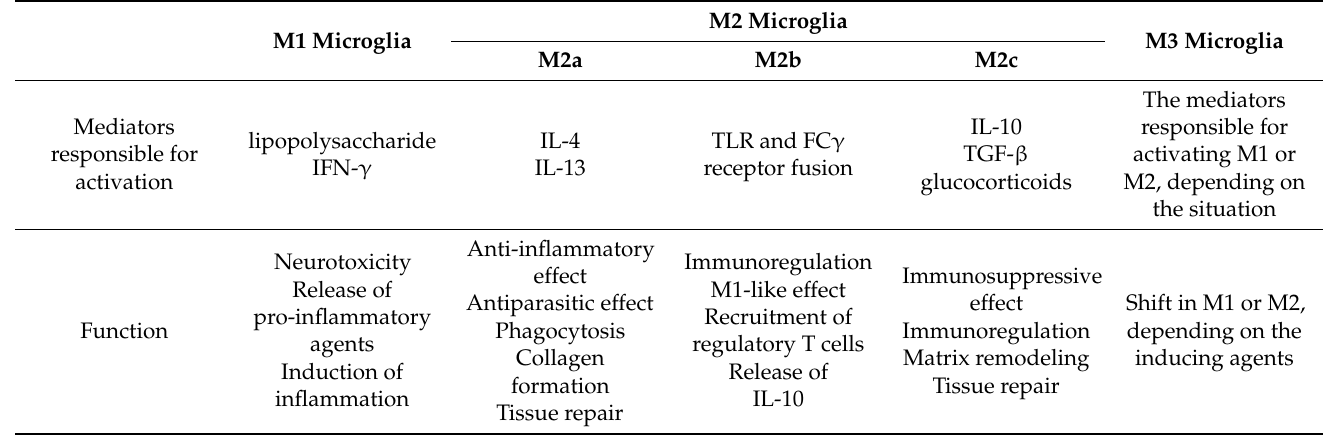
Table 1. Comparison of different microglial phenotypes.